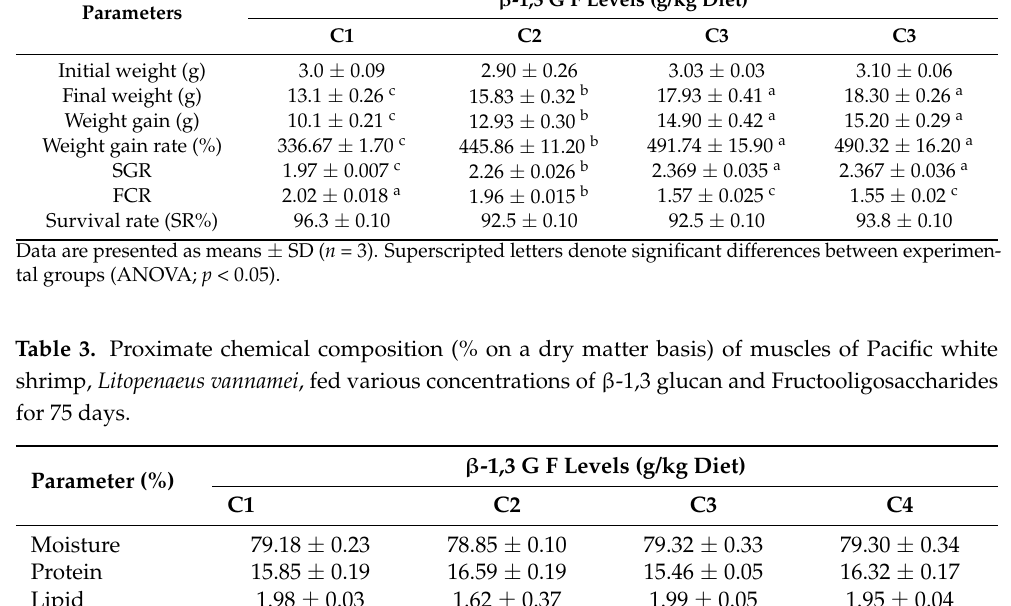
Table 2. Growth performance and survival rate of Pacific white shrimp, Litopenaeus vannamei , fed various concentrations of β -1,3 glucan and fructooligosaccharides for 75 days. Parameters